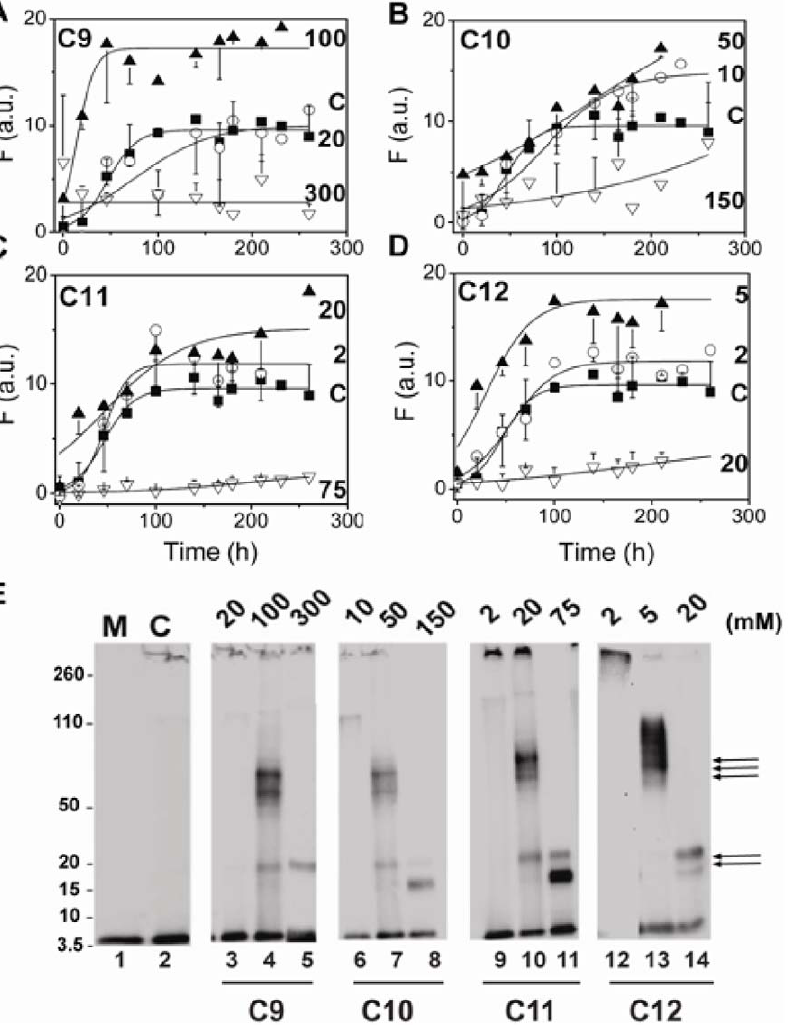
Figure 2. Dependence of A b 42 aggregation on fatty acid concentration monitored by ThT fluorescence. Monomeric A b 42 (25 m M) was incubated at 37 u C in buffer alone (C; & ) or with varying concentrations of fatty acids C9 (A), C10 (B), C11 (C) and C12 (D), above ( , ), below ( # ) or near ( m ) their respective CMCs. The numbers indicated inside the boxes are respective concentrations of fatty acids in mM units. The data are averages of three experiments with different A b 42 purification batches. The data were fit with Eq 1; E) Western blots of the samples in A–D probed using monoclonal antibody, Ab9 after 128 h of incubation. The samples were run on a 12% bis-Tris acrylamide gels with Laemmli buffer. Double arrow indicates 4–5 mers while the triple arrow indicates 12–18 mers of A b 42. ‘M’ represents the monomer control while ‘C’ represents A b 42 sample in the absence of fatty acids. The numbers on top of the gels are fatty acid concentrations in mM units.